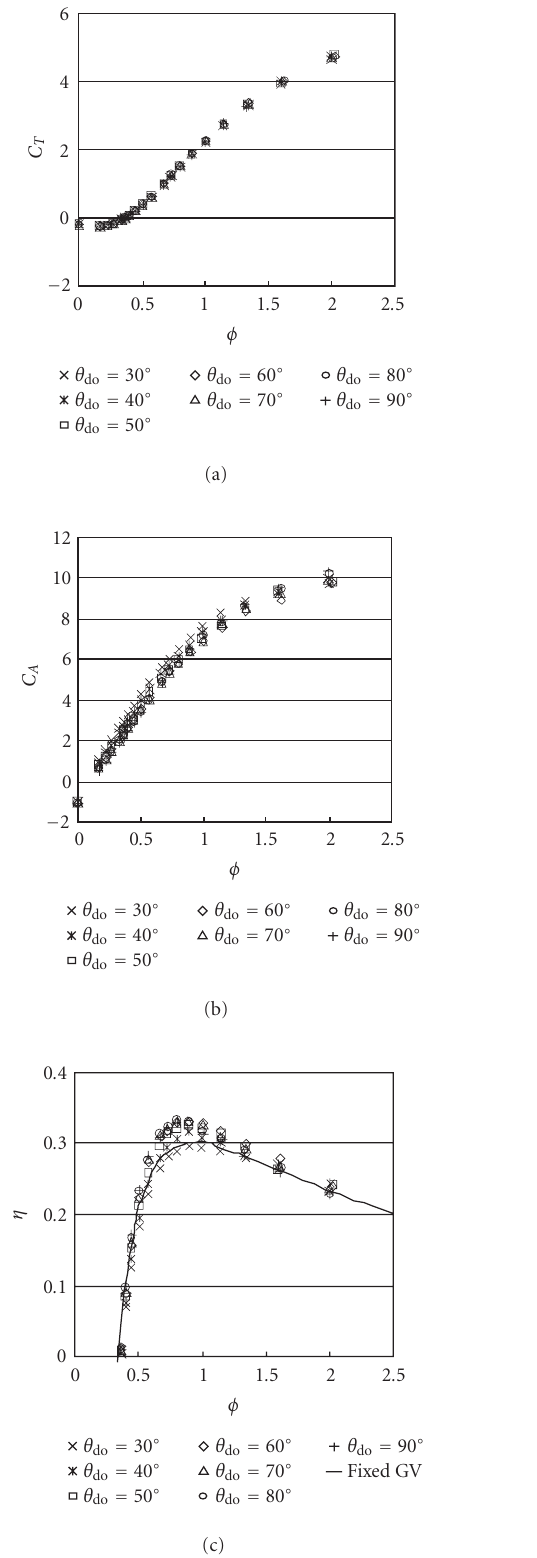
vary periodically in a sinusoidal oscillating flow. In this case, turbine performance should be represented by mean